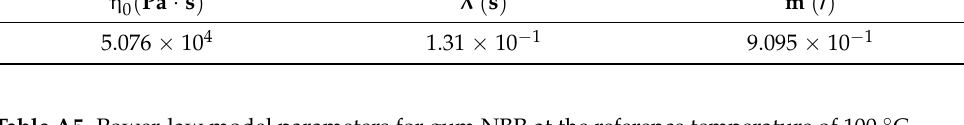
Figure A7. Steady-state shear viscosity of gum NBR compared to power-law and Cross model predictions. Table A4. Cross model parameters for gum NBR at the reference temperature of 100 °C.